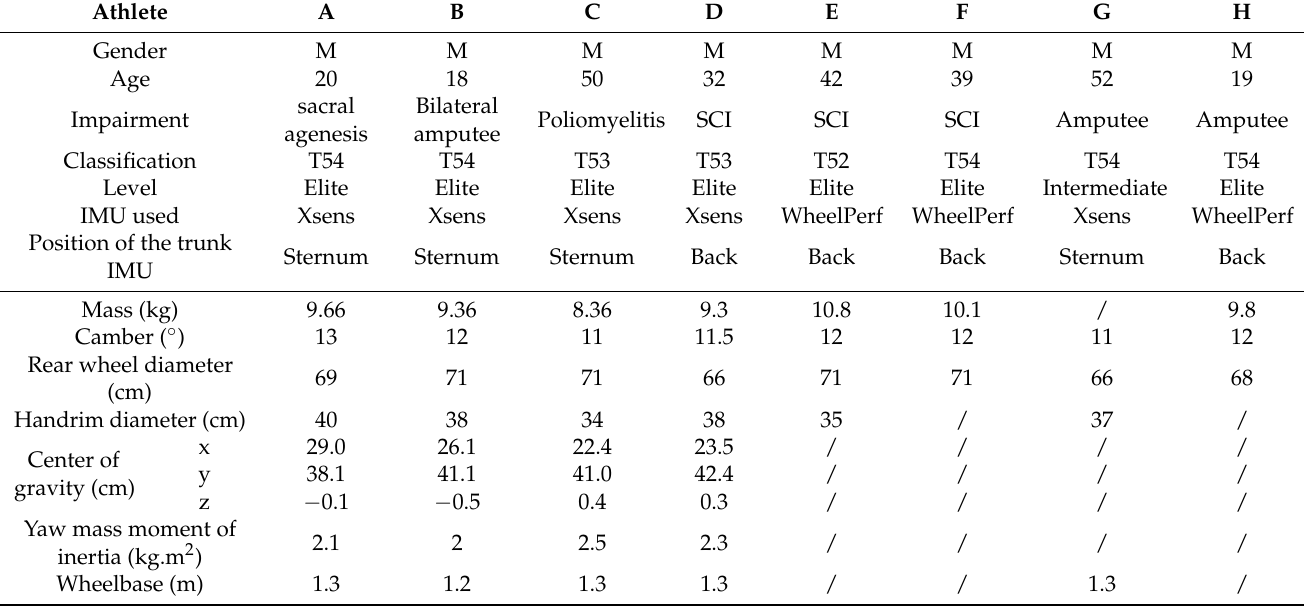
Table 1. Athletes’ demographics and wheelchair characteristics. The coordinates of the center of gravity are given in the MWC local frame defined by its origin placed at the center of the axis connecting the two rear wheel hubs, with the x -axis forward, the y -axis upward and the z -axis medial-lateral to the right (Figure